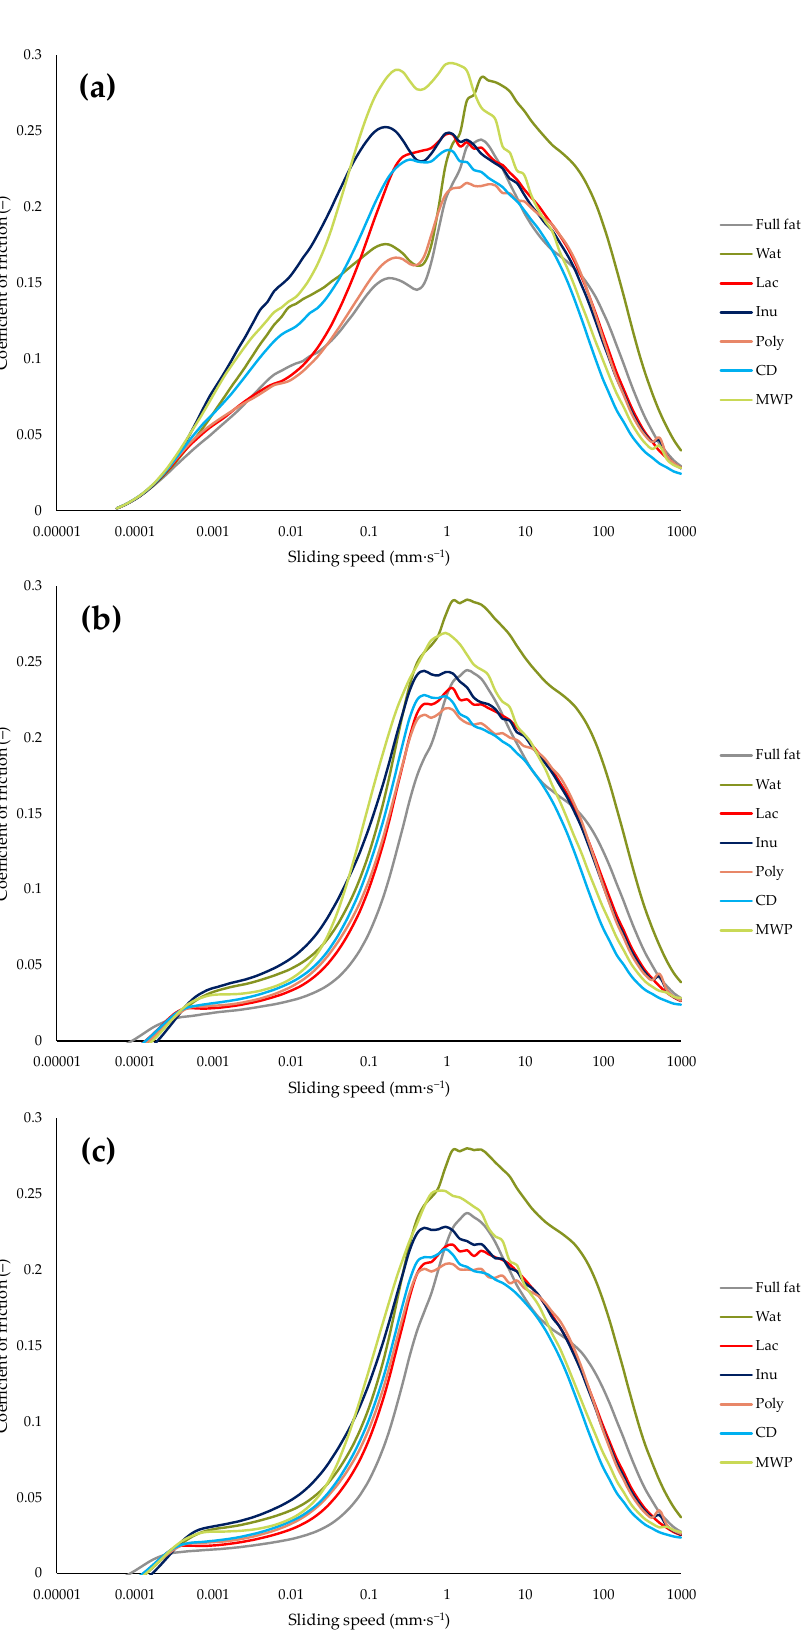
Figure 2. Stribeck curve 1 ( a ), curve 2 ( b ), and curve 3 ( c ): Coefficient of friction versus sliding speed of all emulsions. The curves are the mean values of all four measurements per each of the three batches ( n = 12).